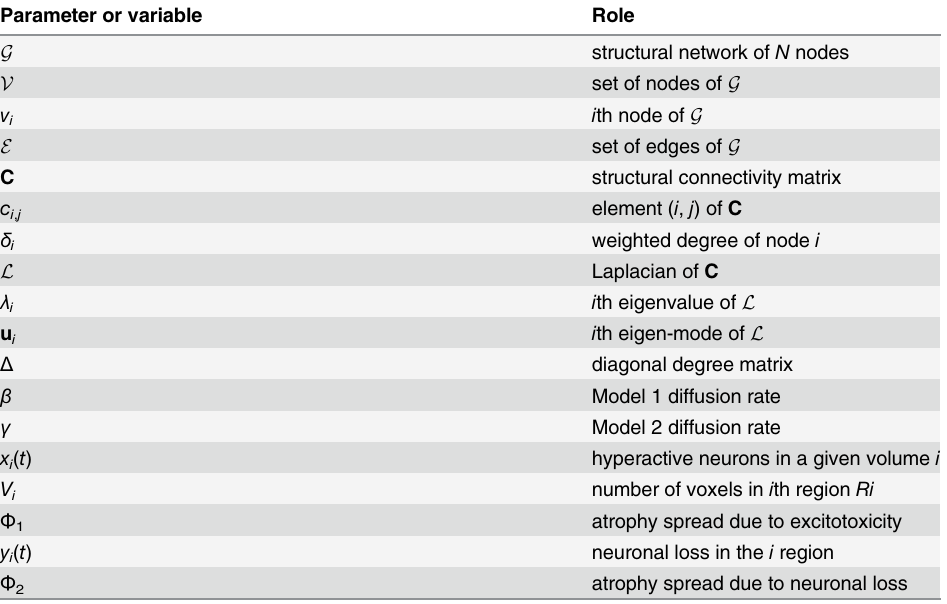
Table 3. Summary of the variables and definitions used in this